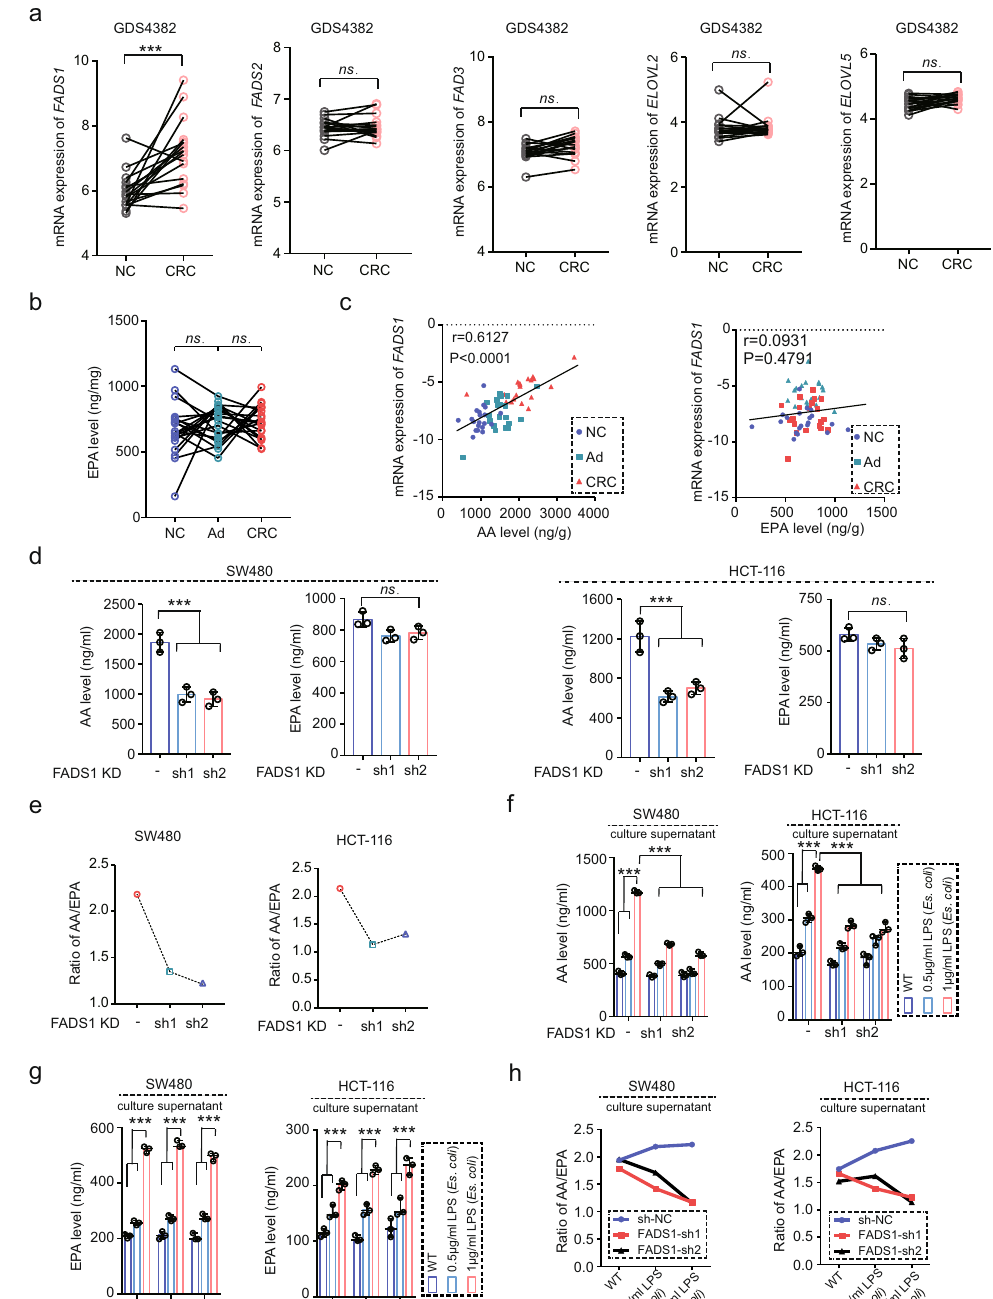
Fig. 3 | FADS1 is upregulated in CRC and controls AA synthesis. a The mRNA expression of FADS1 , FADS2 , FADS3 , ELOVL2 , and ELOVL5 in 17 cases of paired NC and CRC samples from GDS4382, NC: normal colon epithelial tissue, CRC: color- ectal cancer. *** p <0.001. ns indicates no statistical signi fi cance. b EPA levels in 15 cases of paired NC, Ad and CRC samples. ns indicates no statistical signi fi cance. ( n =15 samples per group, means ± s.d.; two-tailed paired t test, n =3 t echnical replicates). c . Correlation between FADS1 expression and AA or EPA levels in 15 cases of paired NC, Ad and CRC samples. The mRNA expression of FADS1 was detected by q-PCR. r indicates correlation coef fi cient. p value indicates statistical difference ( n =15 per group, means ± s.d.; Pearson correlation test, n=3 technical replicates). d Total AA and EPA levels in SW480 and HCT116 cells transfected with shNCorshFADS1.*** p <0.001.nsindicatesnostatisticalsigni fi cance( n =3samples pergroup,means±s.d.;two-tailedunpaired t test, n =3biologicalreplicates). e AA/ EPA ratio in SW480 and HCT116 cells transfected with shNC or shFADS1 ( n =3